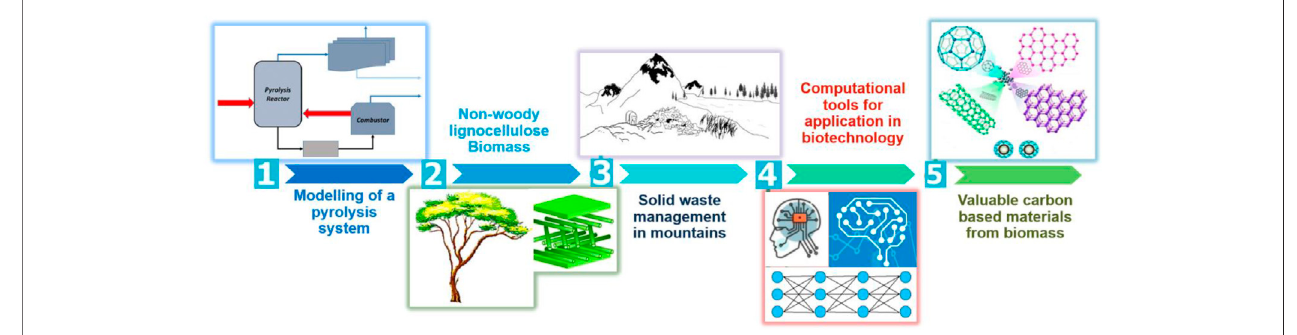
FIGURE 1 | Research innovations in the fi eld of waste to energy conversion - technologies and modelling aspects.